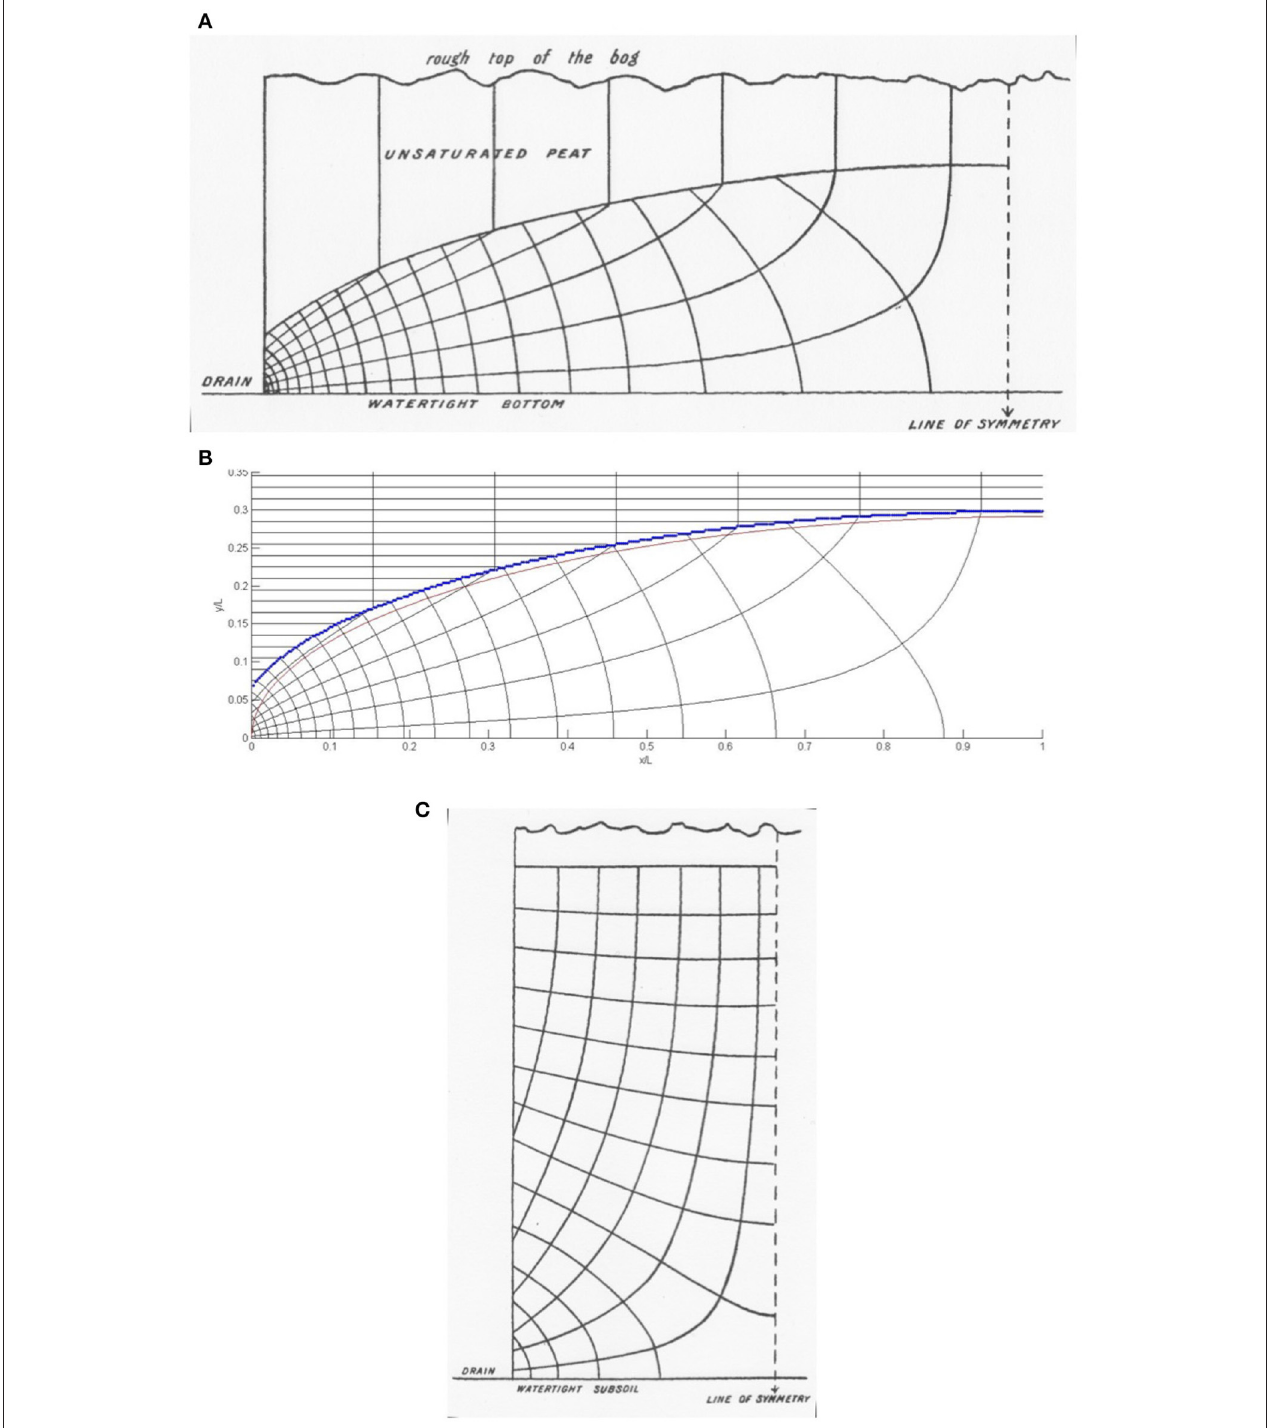
FIGURE 4 | Flow nets (A) for flow to drain with W / ( Kg ρ ) = 0.085, (B) for flow to drain, calculated by a variational method (Knight, 1984; Van der Hoek et al., 1984), (C) for flow to drain with W / ( Kg ρ ) = 0.96. Parts (A,C) copied from, respectively, Figures 3, 4 in Richardson (1908b), with permission from the Royal Dublin Society (RDS).